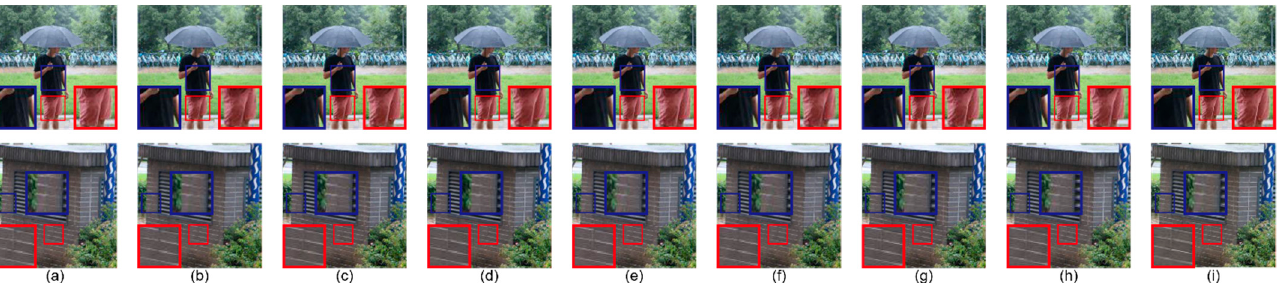
Figure 8. Deraining task performance of the proposed MARCAFNet and state-of-the-art methods when using the Rain100L dataset. ( a ) Rainy image, ( b ) RESCAN, ( c ) PReNet, ( d ) LPNet, ( e ) MSPFN,